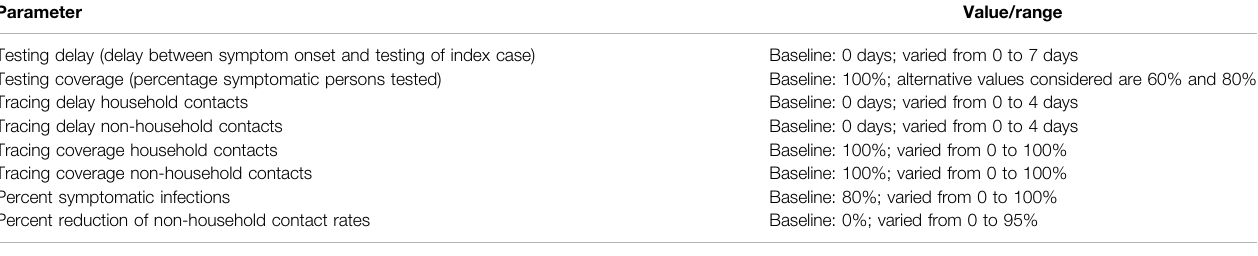
TABLE 2 | Parameters related to diagnosis and contact tracing.